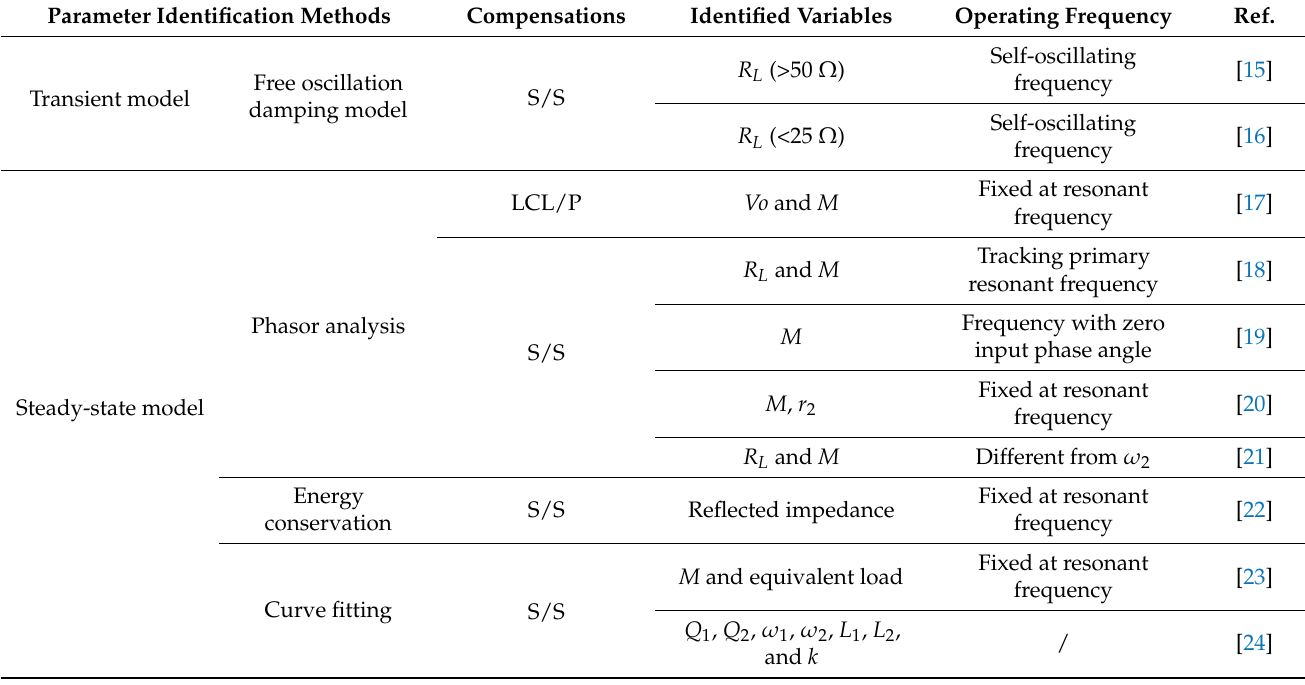
Table 1. Main transmitter-side parameter estimation